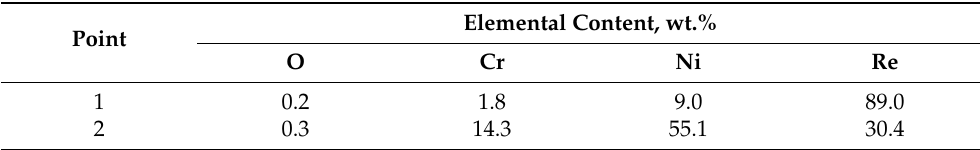
Figure 5. EDS map of cross-sections of NiCr + 20Re powder. Table 4. Results of EDS analysis of NiCr + 30Re powder surface. Point numbers correspond to points chosen for analysis, shown in Figure